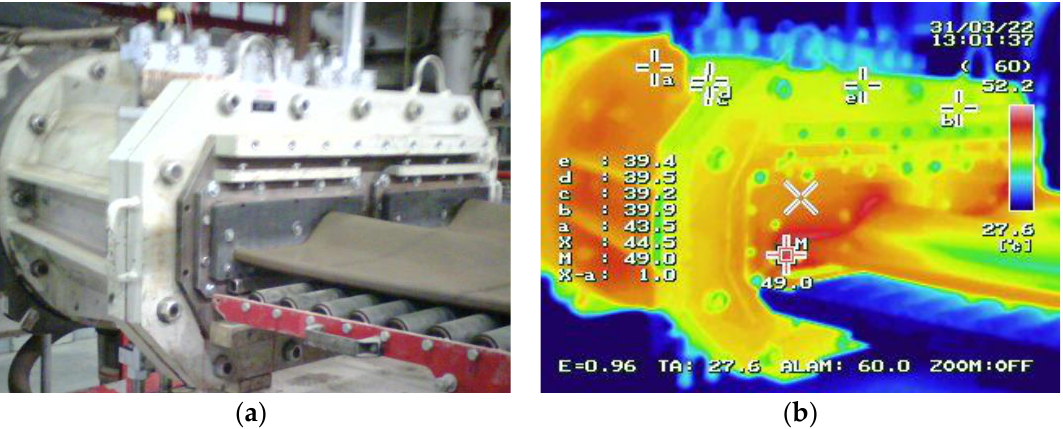
Figure 3. View of: ( a ) a photograph of the strand extruded through a pug mill, ( b ) a thermovision diagram of the clay strand and tool set.